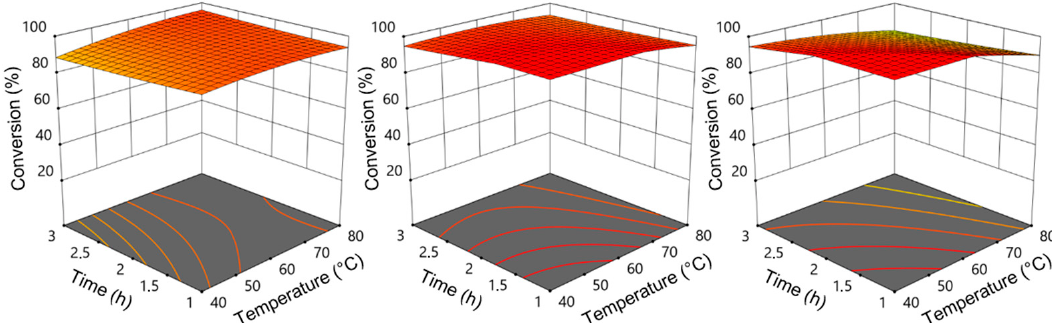
Figure 5. The 3D plots obtained when the molar ratio of the reactants was the highest (10:1) and the value of the mass fraction of the catalyst was the lowest (1%, ( left )), medium (2%, in the ( middle )) and the highest (3%, ( right )).